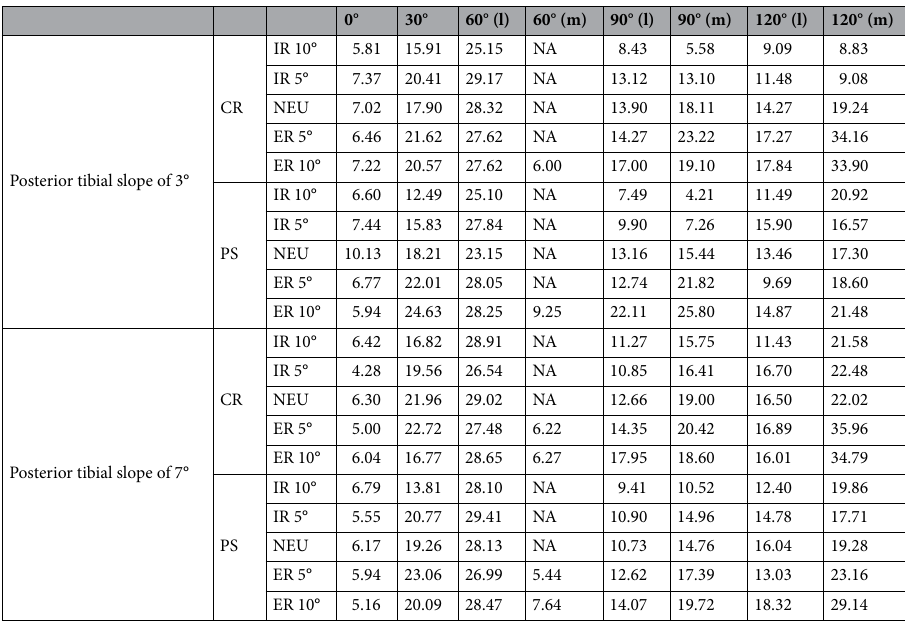
Table 1. Patellofemoral contact area during flexion. CR cruciate-retaining design, PS posterior-stabilized design, IR internal rotation, NEU neutral rotation, ER external rotation, l lateral, m medial, NA not available.